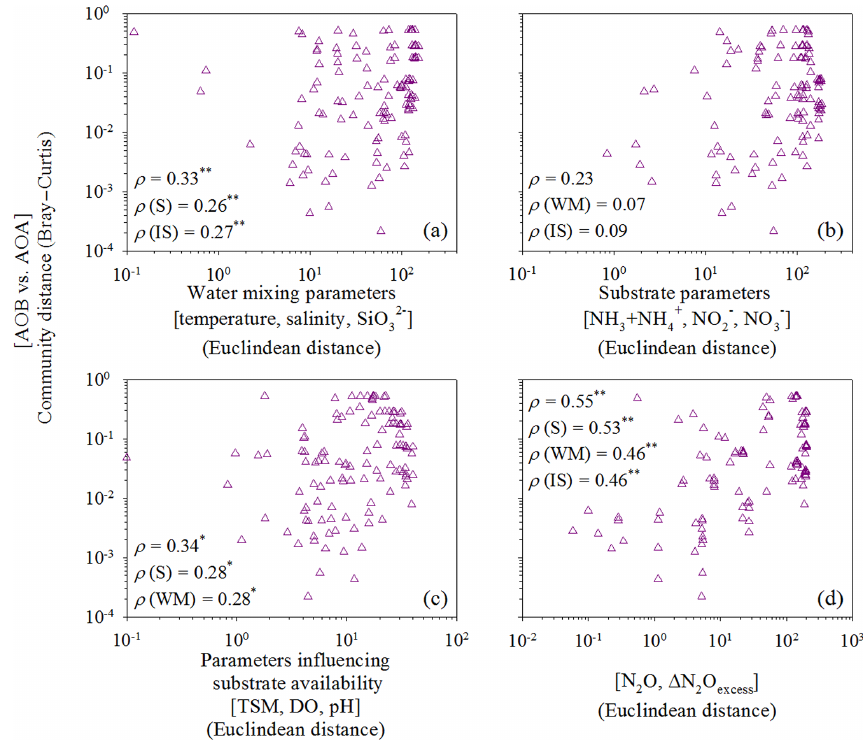
Figure 6. Correlations between the relative abundance of AOB versus AOA and (a) water mixing parameters (temperature, salinity, and silicate), (b) substrate parameters (ammonia/ammonium, nitrite, and nitrate), (c) parameters influencing substrate availability (TSM, DO, and pH), or (d) N 2 O parameters (N 2 O and (cid:49) N 2 O). The ammonia oxidizer matrix was calculated according to the relative AOA and AOB abundances. Dissimilarity matrices of the relative abundance of AOB amoA and AOA amoA were based on Bray–Curtis distances and environmental factors were based on Euclidean distances between samples. Standard and partial Mantel tests were run to measure the correlation between two matrices. Spearman correlation coefficient ( ρ ) values are shown for standard (first value) and partial Mantel (second, third, and fourth) tests. The P values were calculated using the distribution of the Mantel test statistics estimated from 999 permutations. ∗ P< 0 . 05; ∗∗ P< 0 .